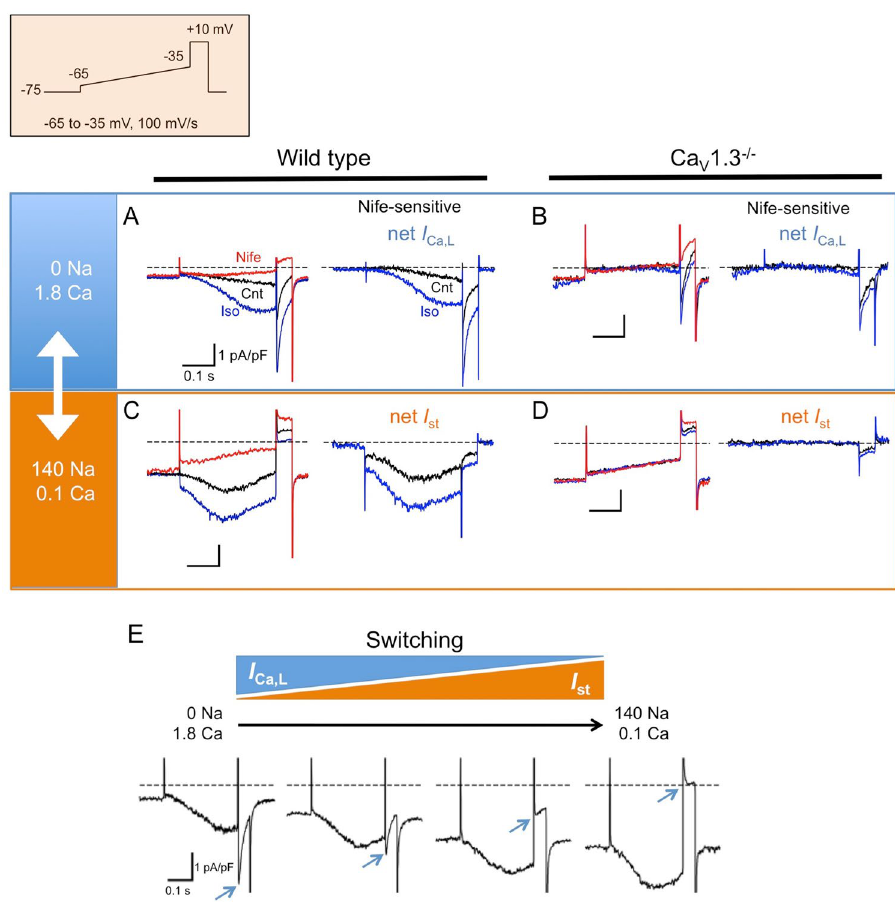
Figure 4. Ca V 1.3 mediates both I Ca,L and I st in the SAN diastolic depolarization range. ( A , C ) Representative whole-cell membrane currents recorded from the same wild-type SAN cell using two different external solutions: TEA + -substituted, Na + -free external solution containing 1.8 mM Ca 2 + ( A ) to record I Ca,L and 140 mM [Na + ] o solution containing 0.1 mM Ca 2 + plus 10 µ M TTX ( C ) to record I st . The cell was first held at − 75 mV. Then, a slow ascending ramp (100 mV/s) voltage command was used to elicit I Ca,L or I st ( top panel ), from − 65 to − 35 mV, followed by depolarization to + 10 mV for 50 ms. Under distinct external conditions, currents were recorded in the absence ( black trace, left panel ) and presence ( blue trace, left panel ) of 100 nM Iso, and after addition of 1 µ M nifedipine ( red trace, left panel ). Nifedipine-sensitive net I Ca,L and I st in the absence ( black trace, right panel ) and presence ( blue trace, right panel ) of Iso were obtained by digital subtraction of current traces before and after application of nifedipine ( right panel ). ( B , D ) Representative I Ca,L ( B ) and I st ( D ) in Ca V 1.3 − / − SAN cells, recorded using the same protocol as in ( A , C ), respectively. ( E ) Sample current recordings in a wild- type SAN cell during gradual replacement of the external solution for I Ca,L recording with that for I st recording in the presence of Iso. Arrows indicate the peak of I Ca,L